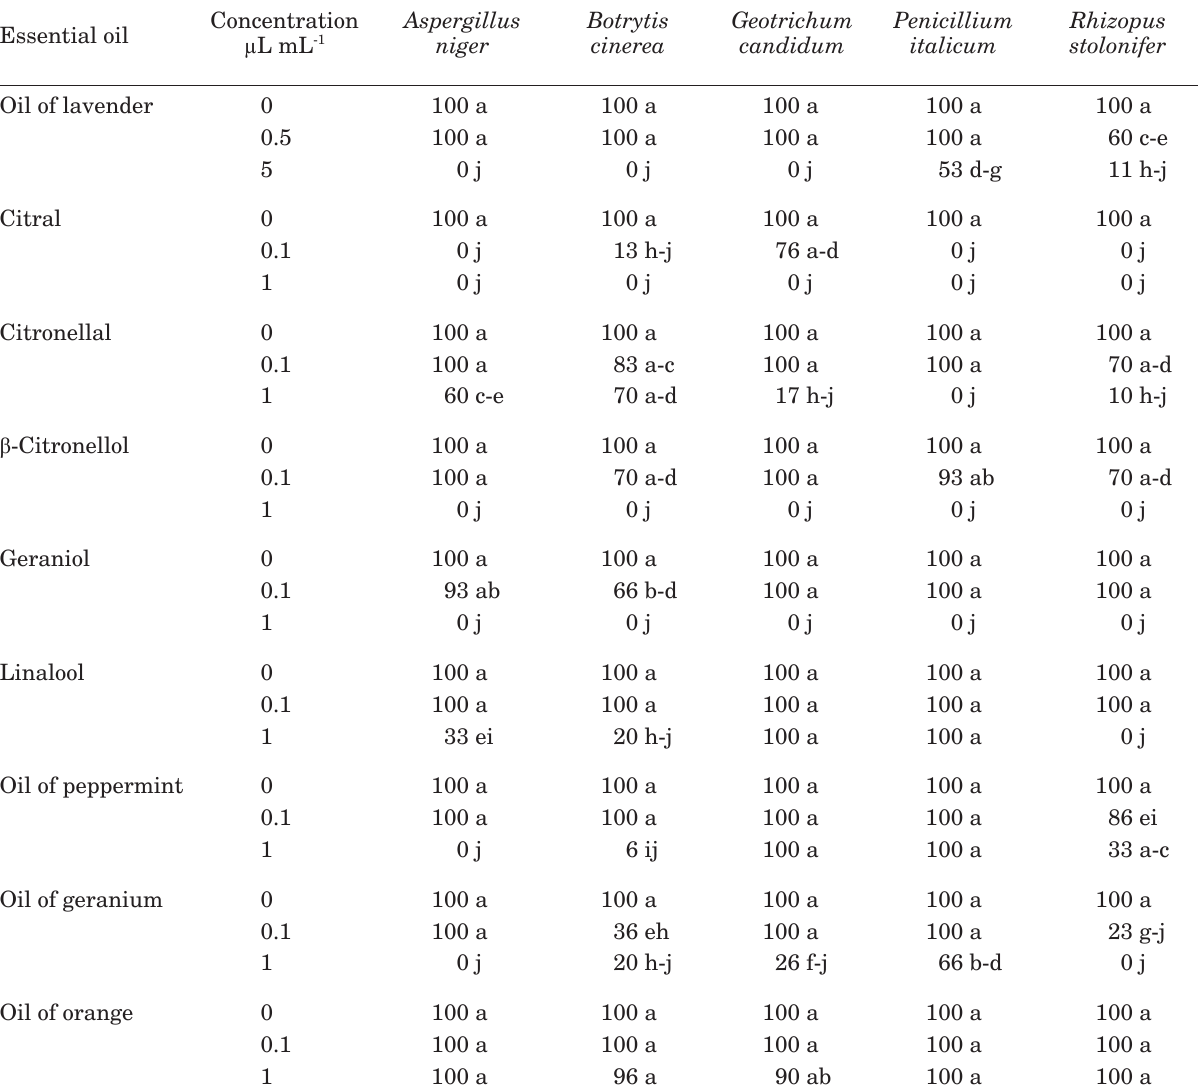
Table 3. Mean percentage spore germination of different fungi exposed to different essential oils a